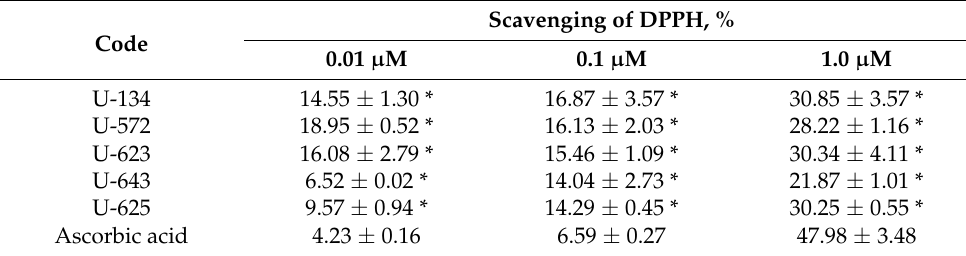
Table 2. Free radical scavenger capacity of selected 5,8-dihydroxy-1,4-naphthoquinone derivatives.